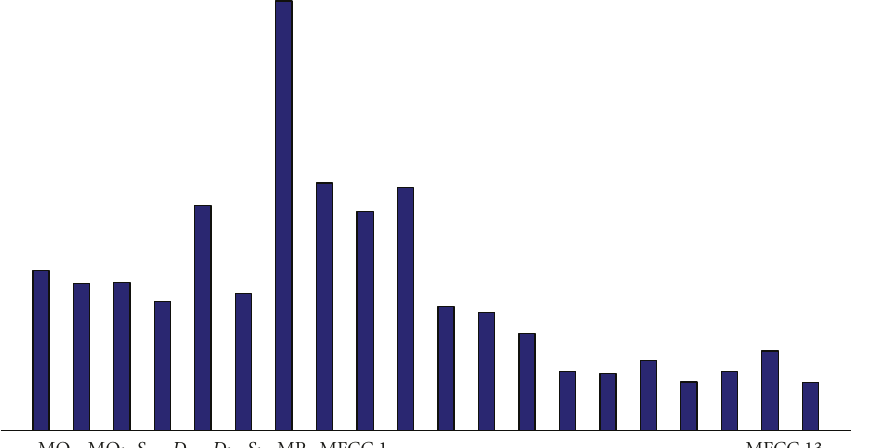
Figure 16: The relative height of each feature represents the relative importance of the feature compared to the other